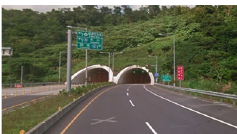
Figure 1: The entrance to the studied tunnel.